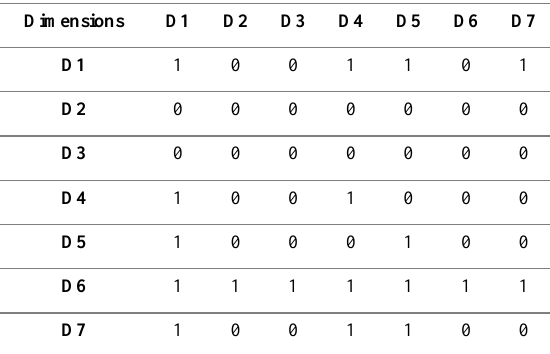
Table 12. Influential relation matrix based on the threshold value of matrix T